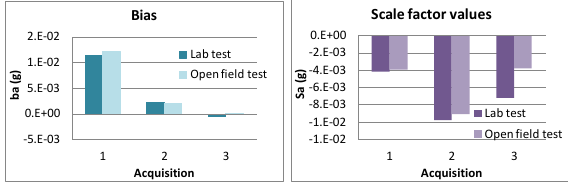
Figure 3. Equipment during calibration of the static test. Laboratory and open field tests